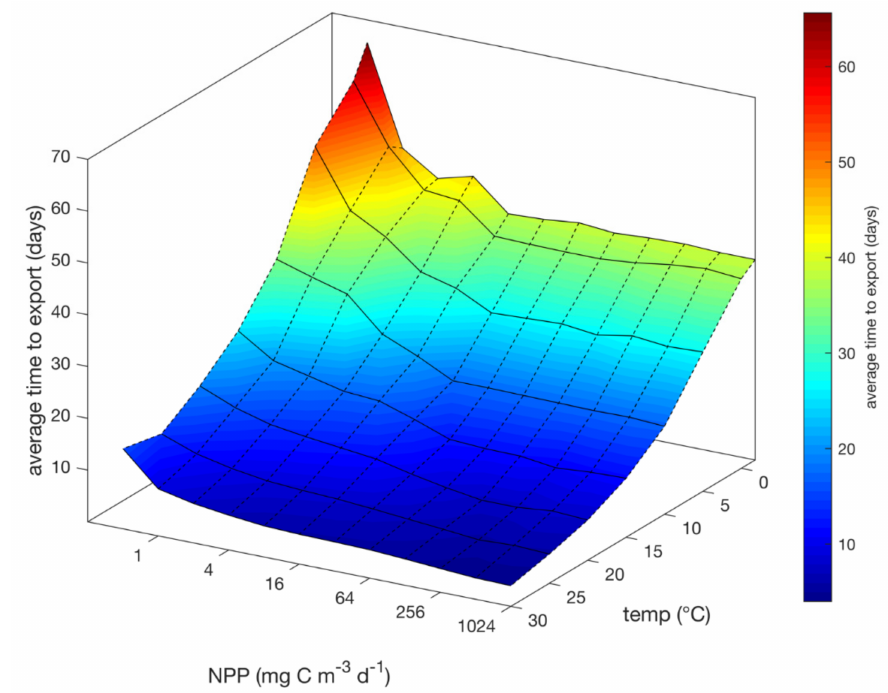
Figure 4. Average time between the production and export of organic matter from the steady state food web model as a function of temperature and NPP. The average time is the integral of the product of export and time divided by the total